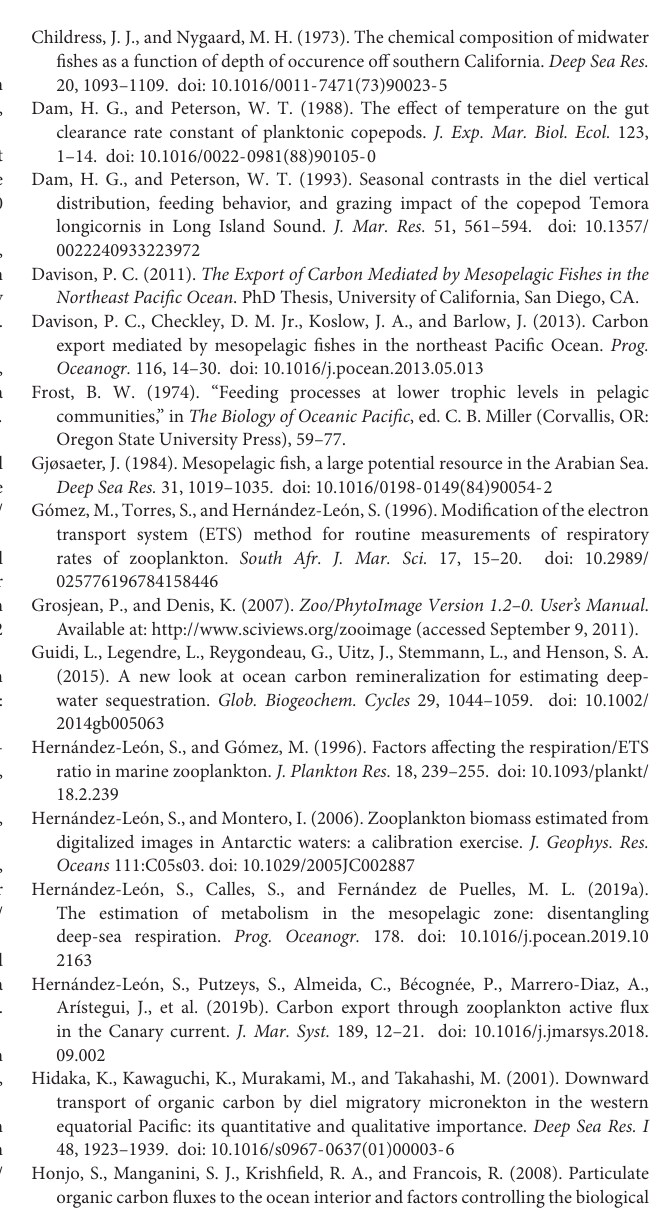
FIGURE S1 | Relationship between total active flux of zooplankton and